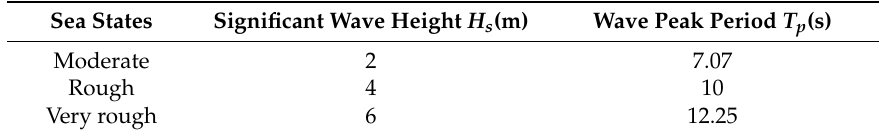
Table 1. Sea states for floating offshore wind turbine (FOWT) model verification and control design.